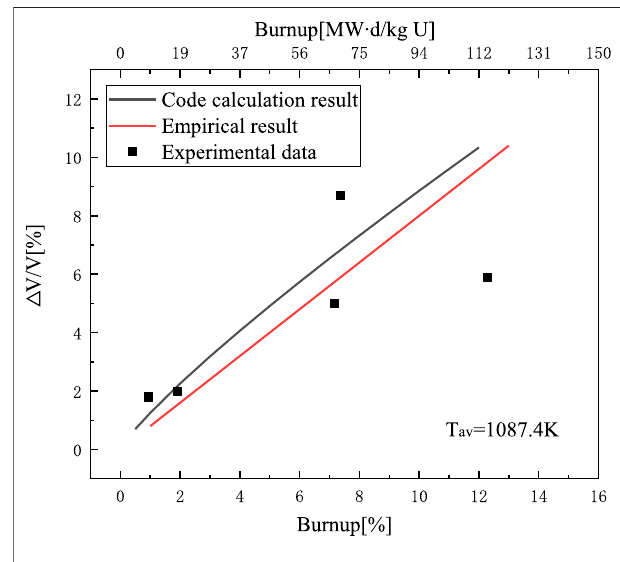
FIGURE 6 | Fuel volume swelling versus